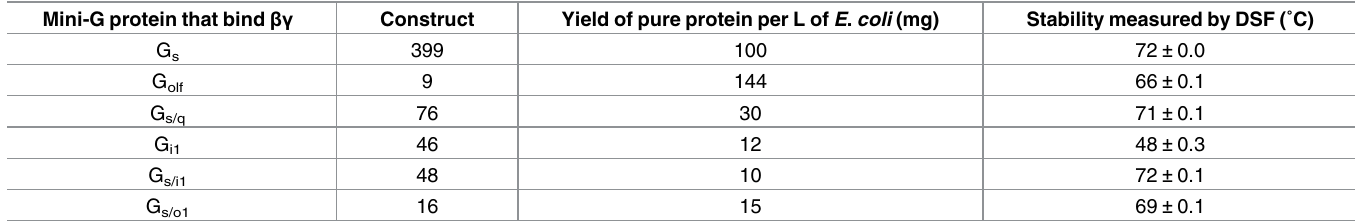
Table 2. Mini-G proteins that bind βγ subunits and their characteristics. Mini-G protein that bind βγ Construct Yield of pure protein per L of E . coli